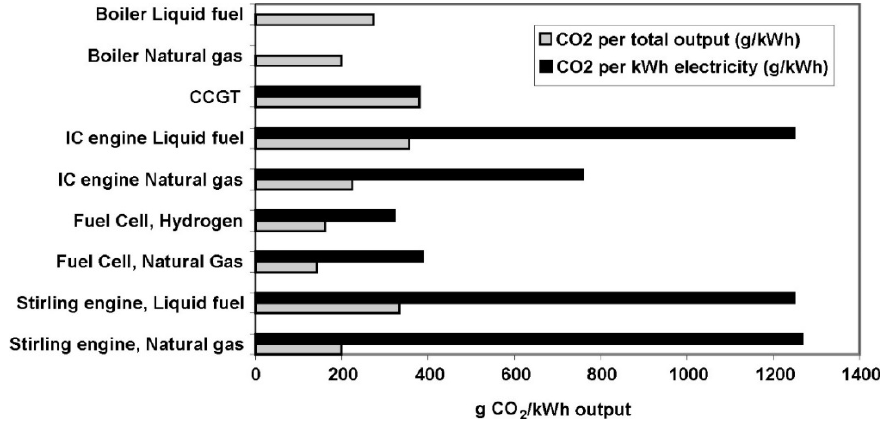
Figure 12. CO 2 emissions of each micro-CHP system type. Source: Reprinted with permission from Ref. [18]. 2011, University of Nis—Faculty of Mechanical Engineering.